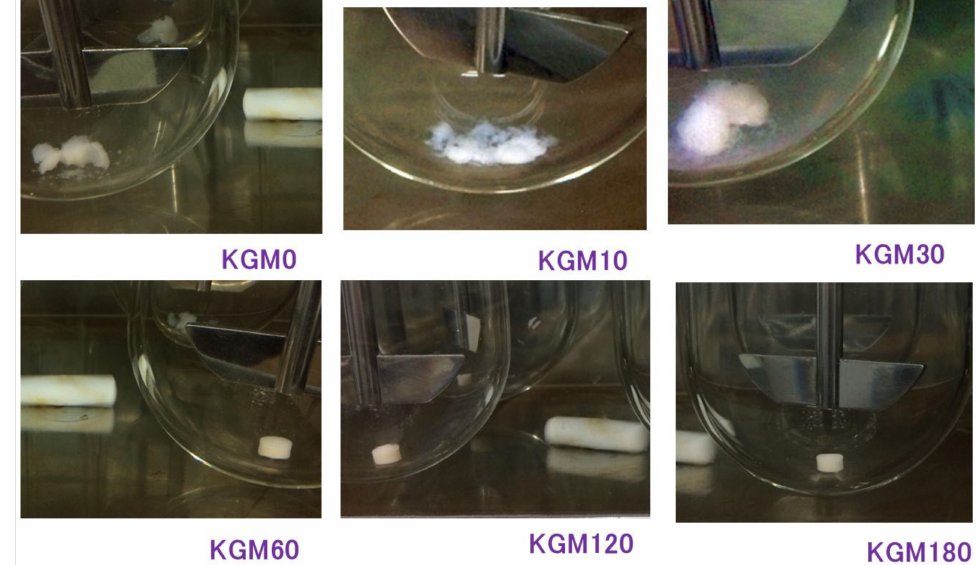
Figure 5. Photographs of the KGMH tablets after 24 h during the drug release